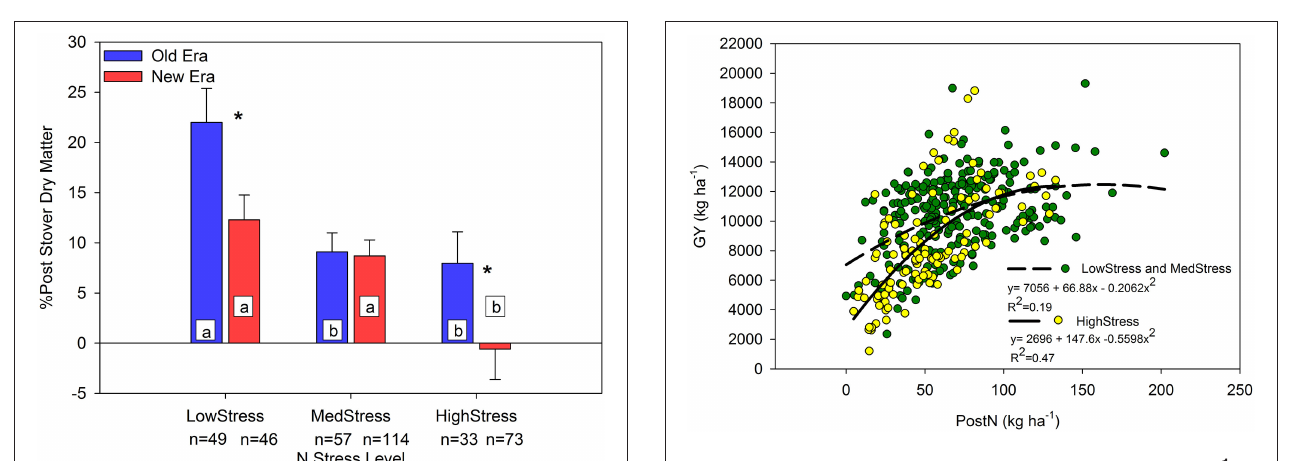
FIGURE 5 | Quadratic relationship between post-silking N (kg ha − 1 ) and grain yield (kg ha − 1 ) by N stress level as determined by NNI at the R1 stage. The LowStress and MedStress lines were combined because there was no significant difference between these